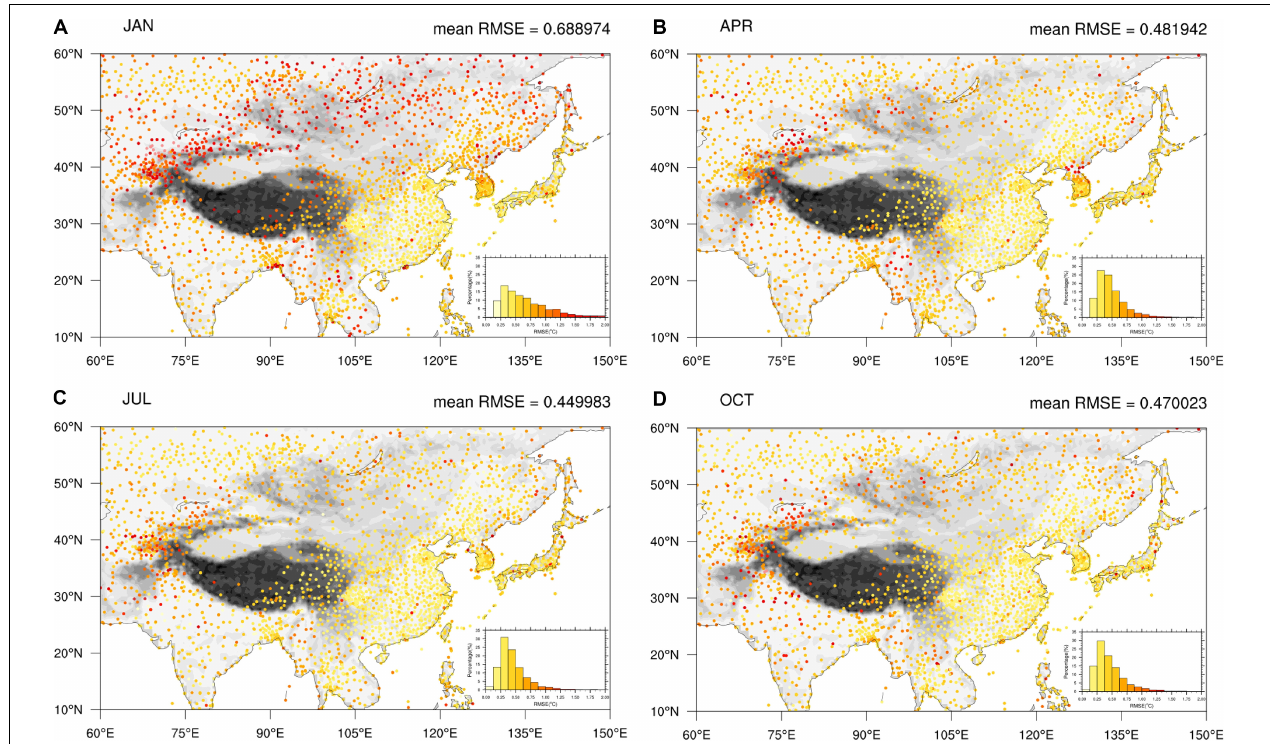
FIGURE 6 | RMSEs of the LSAT anomaly over Pan-East Asian from 1900 to 2018 at each station in 4 months [January (A) , April (B) , July (C) , and October (D) ] calculated by leave-one-out cross validation.